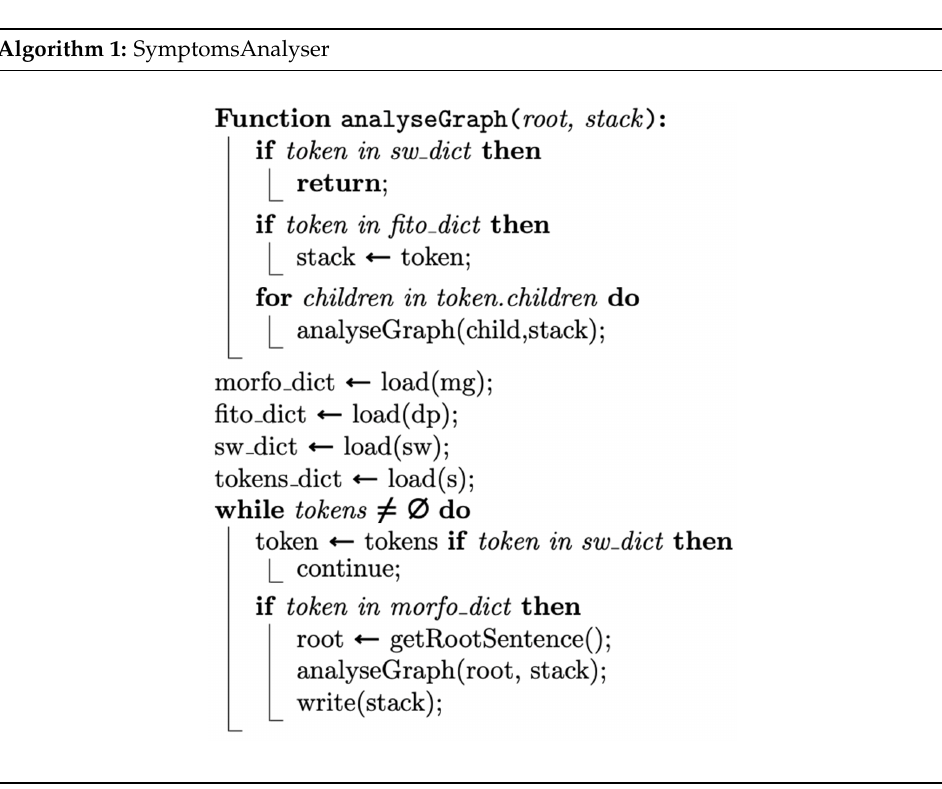
Figure 3. Pseudocode of the two-step method for symptoms